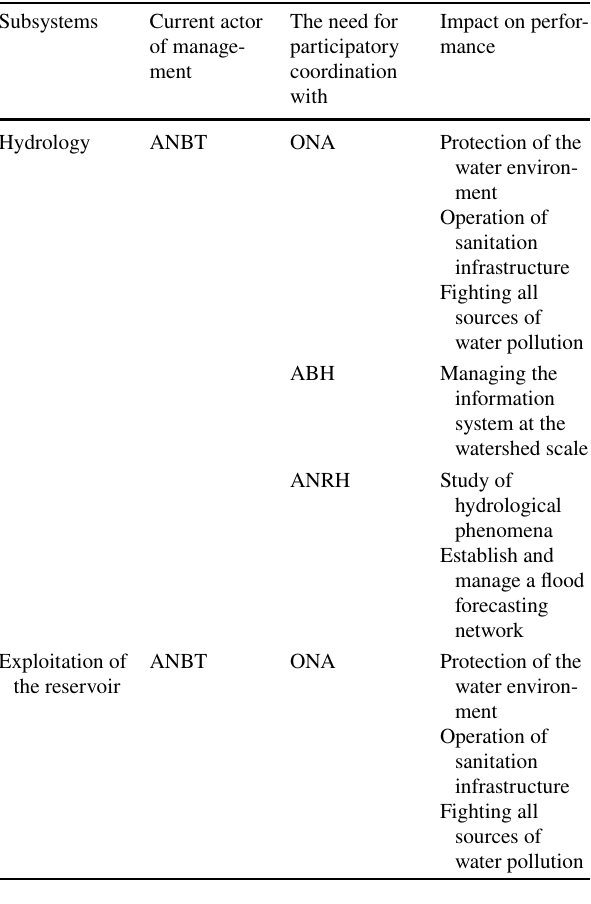
Table 6 Institutional improvements for the integrated management water resources in Boughrara